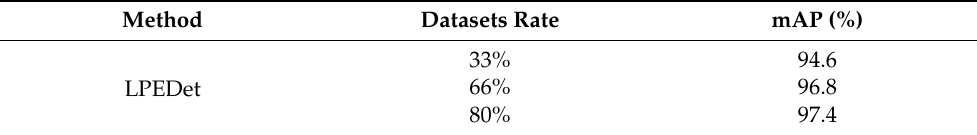
Table 7. Comparison of experimental results for different data volumes on